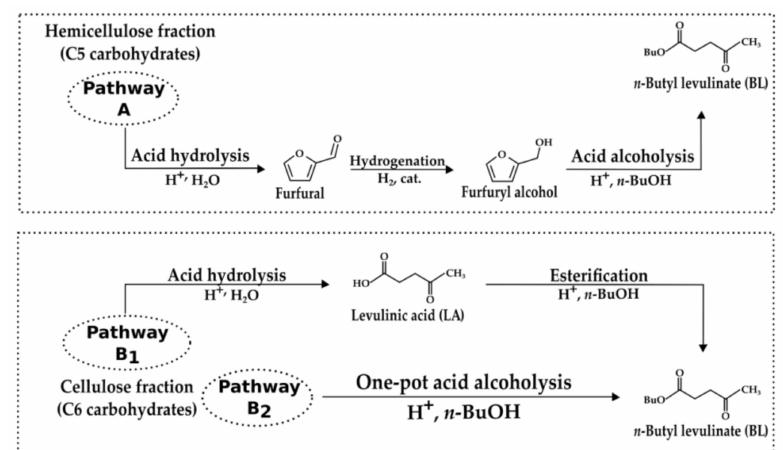
Figure 1. C5 and C6 sugar-based routes to n -butyl levulinate.